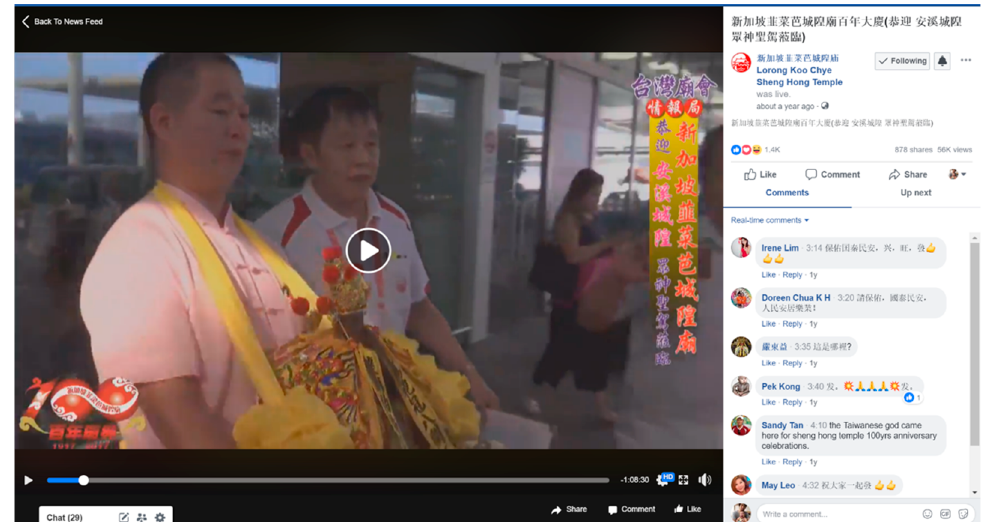
Figure 3. Screenshot of the moment when the effigy of Anxi Cheng Huang Ye leaves Singapore’s Changi Airport to make the journey to Sheng Hong Temple, 22 September 2017. Source: Facebook https://www.facebook.com/LKCSHENGHONGTEMPLE/videos/1697361890305038 / (accessed on 18 February 2019).